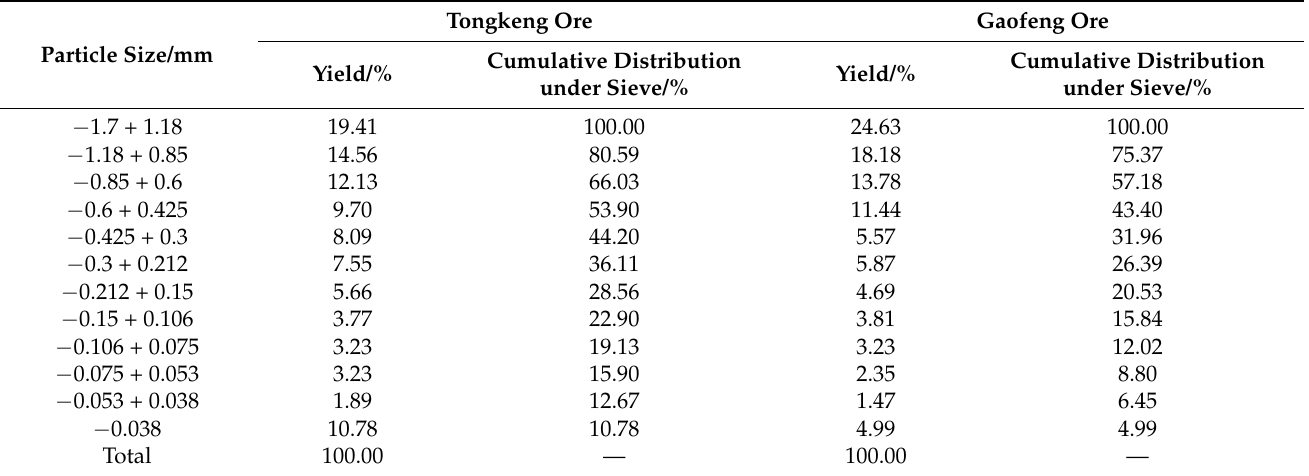
Table 1. Particle size distribution of two types of ores’